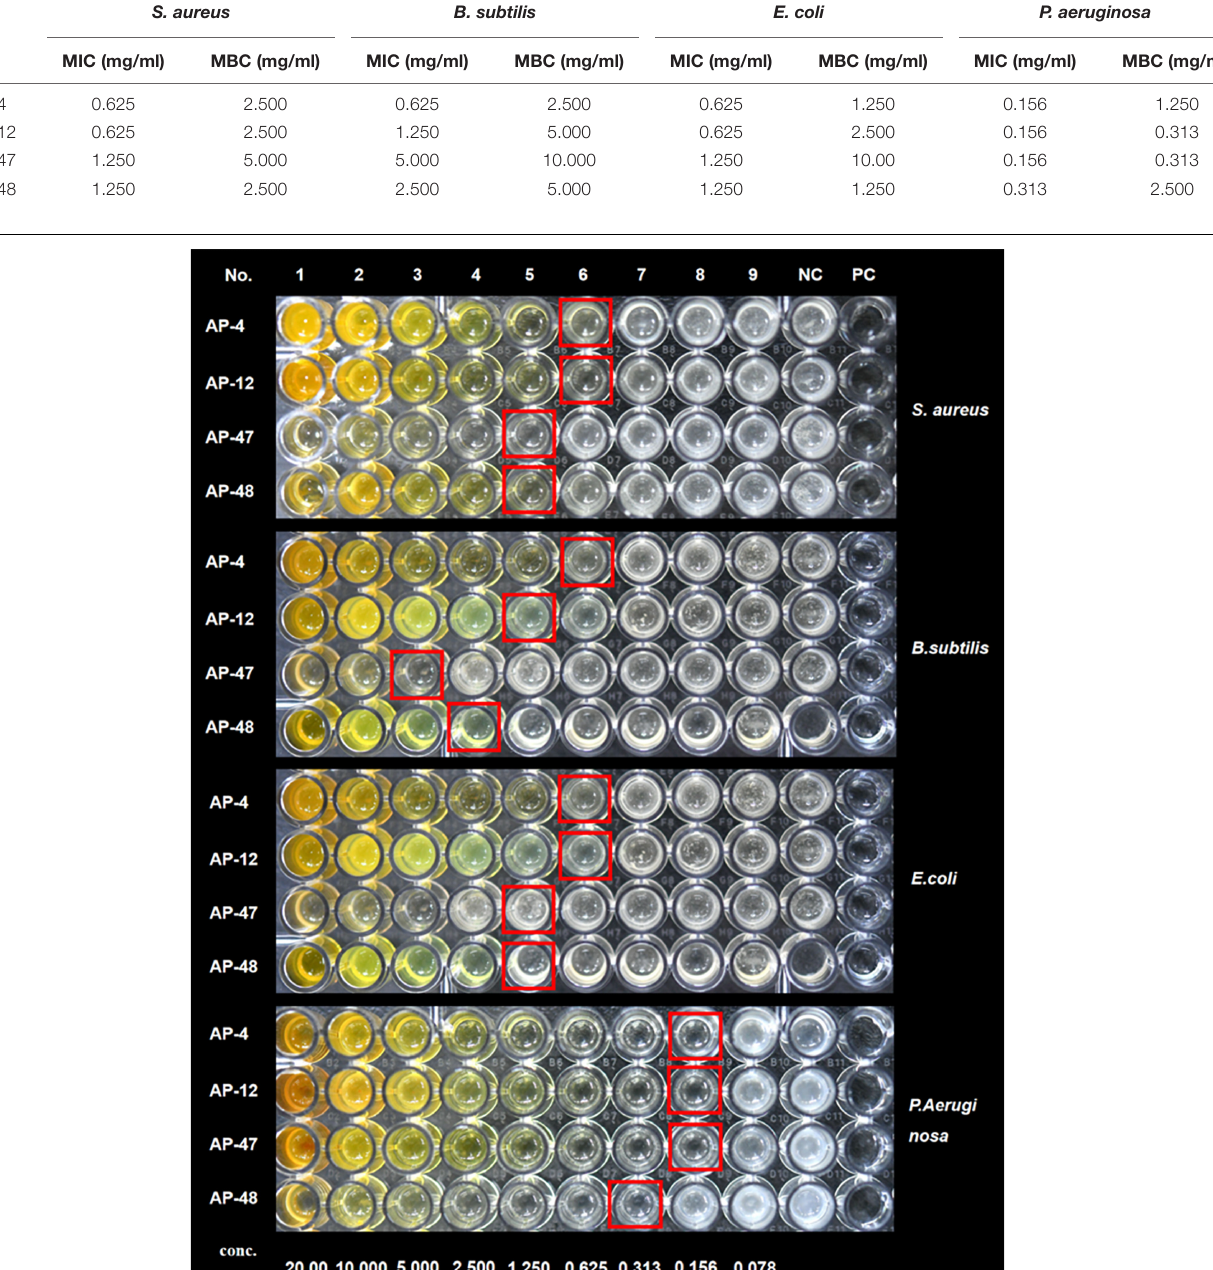
TABLE 4 | Determination of minimum inhibitory concentration (MIC) and minimum bactericidal concentration (MBC) of AP-4, AP-12, AP-47, and AP-48 ( n = 3). S. aureus